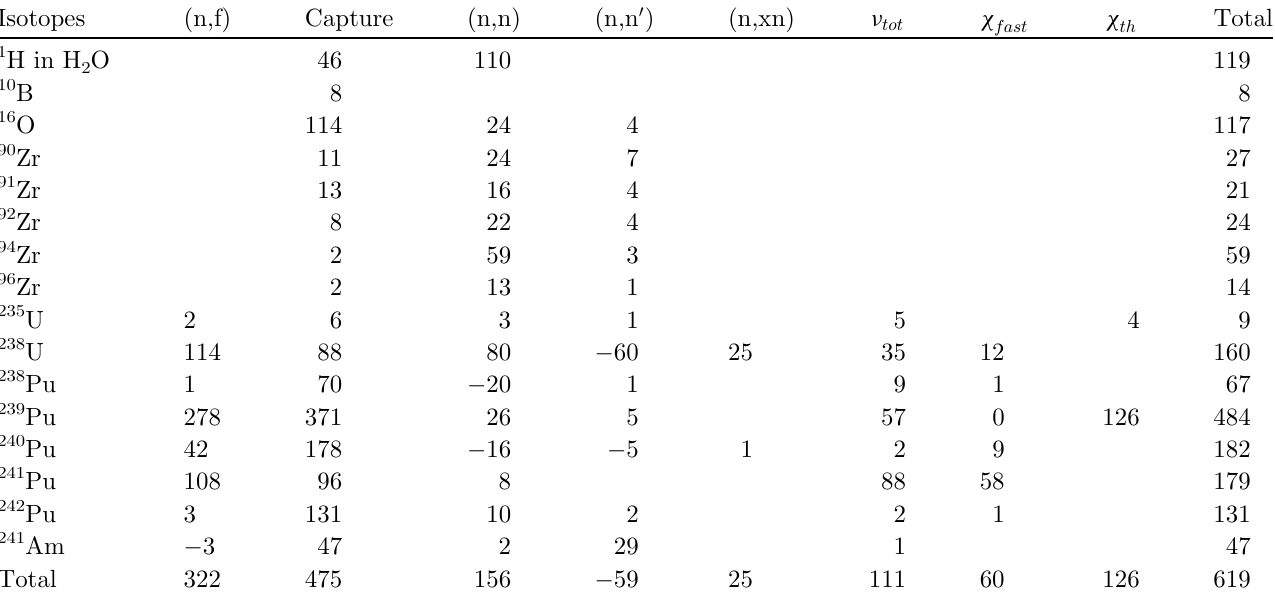
Table 7. Example of uncertainties on the reactivity (MOX con fi guration at room temperature) in pcm due to the O comes from the present work. The other contributions were calculated with nuclear data. The contribution of 1 H in H 2 the covariance data base COMAC [32] developed at the CEA of